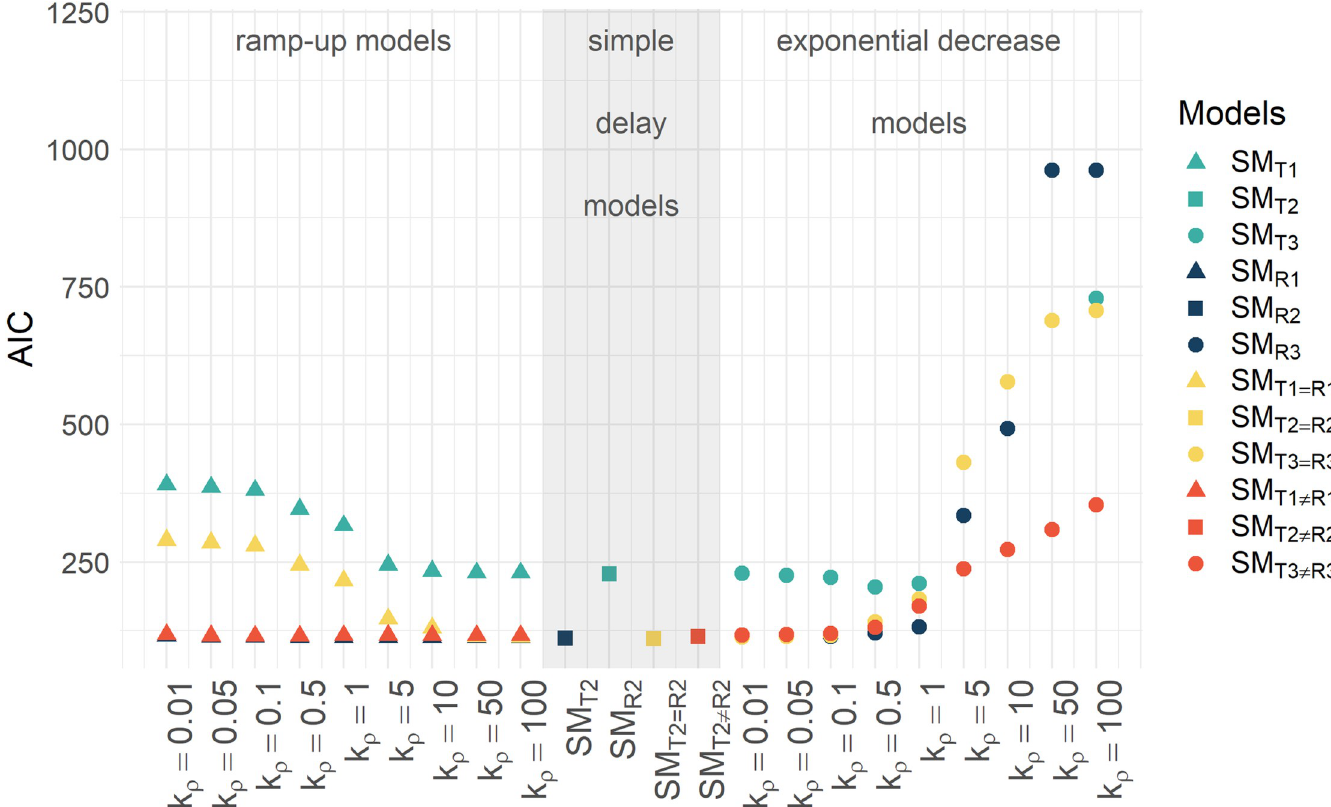
Fig 2. AICs of the HCV RNA secretion models. Best-fit model AICs of the HCV RNA secretion models (Eqs 1 to 4) when the parameter k ramp-up or limitation was varied (see S1 Data). [ ▲ = ramp-up models, ■ = simple delay models, ● = exponential decrease models; green = secretion exclusively from site of translation, blue = secretion exclusively from RC, yellow = equal secretion from site of translation and RC ( ρ T = ρ R and τ T = τ R ), red = individual secretion from site of translation and RC ( ρ 6¼ ρ and τ 6¼ τ T R T R